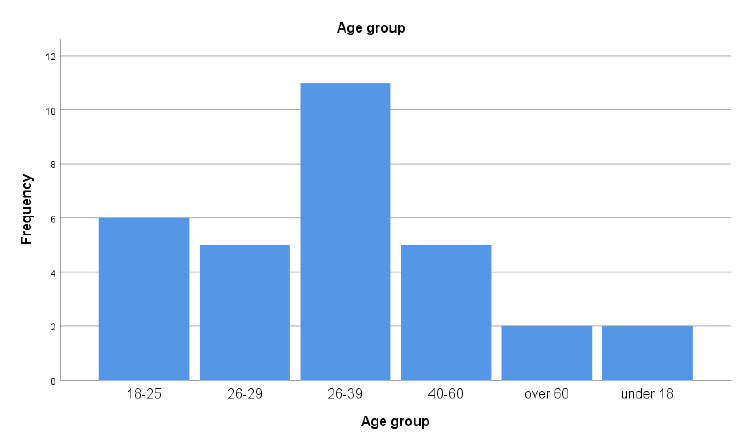
Figure 1. Distribution of respondents by a company type